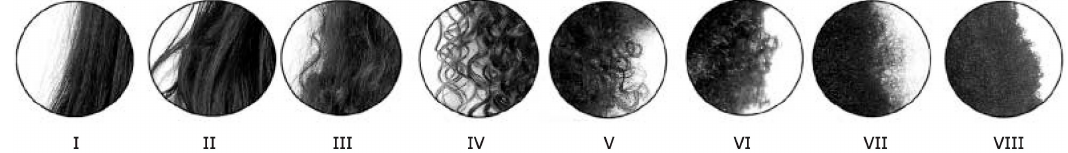
Figure 6. Partitioning of hair into the eight curliness types. Reproduced with permission from [62], published by John Wiley & Sons, Inc., 2007.